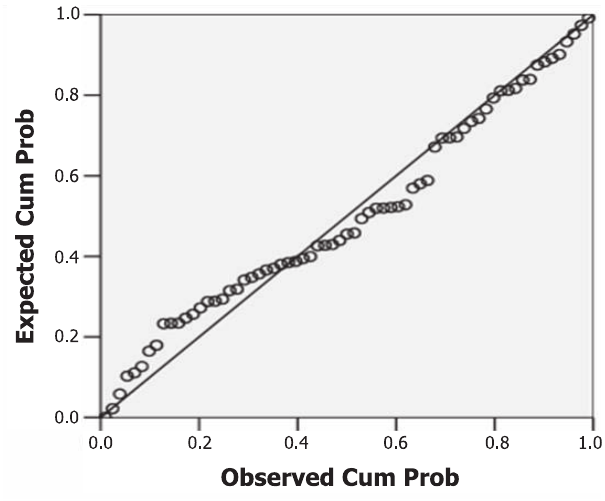
Fig. 5: Normal P-P Plot of Regression Standardized Residual, Dependent Variable: K ( Me